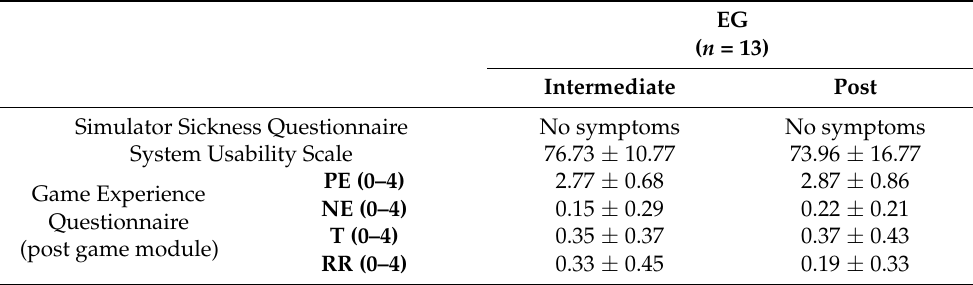
Table 6. Sickness, usability, and post gaming experience in the experimental group.